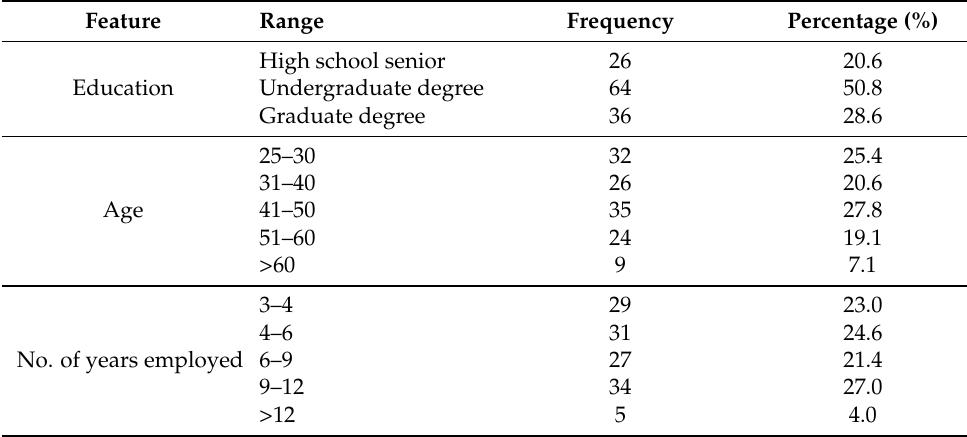
Table 2. Individual respondents’ statistics from the